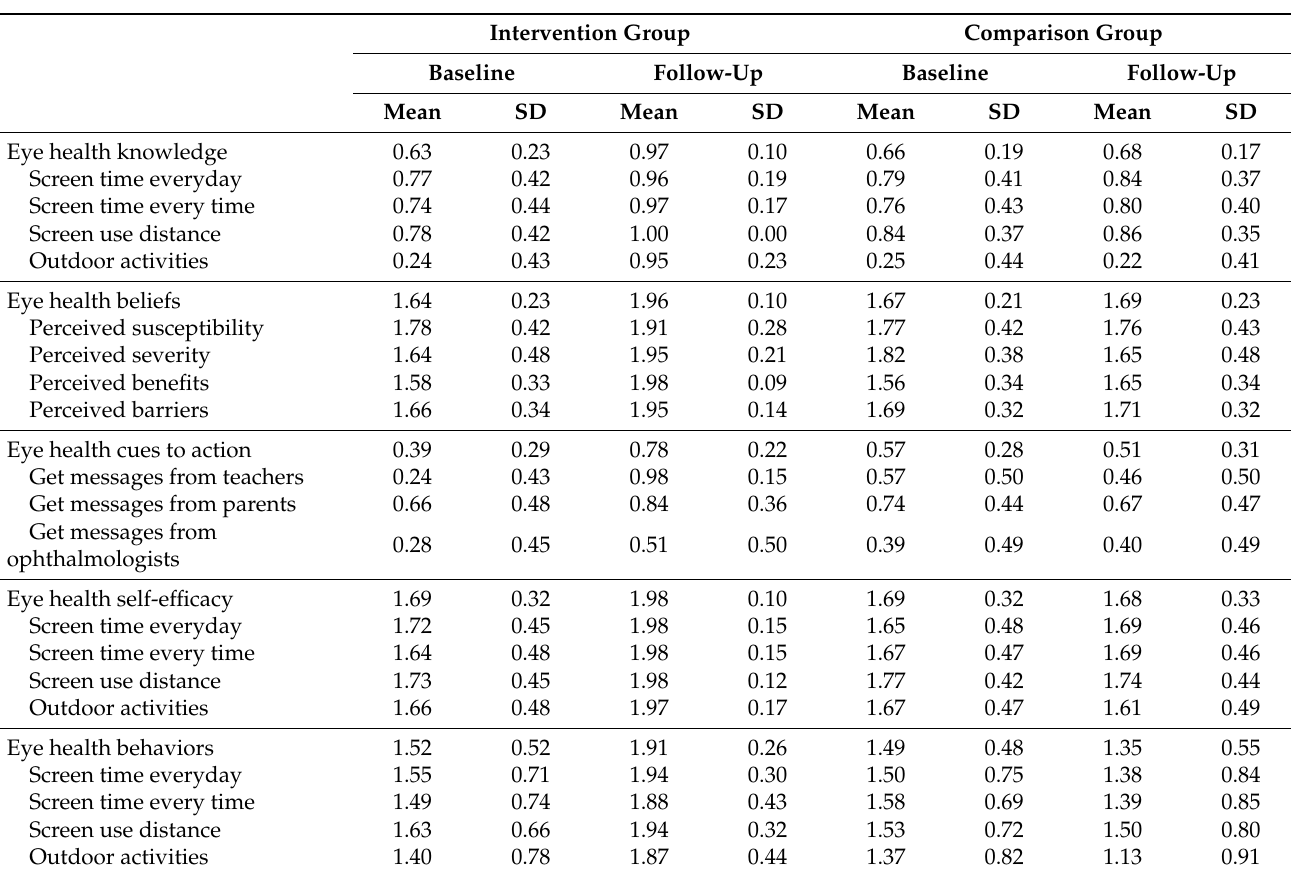
Table 2. Children’s eye health knowledge, beliefs, cues to action, self-efficacy, and behaviors for the intervention and comparison groups based on the baseline and follow-up surveys.